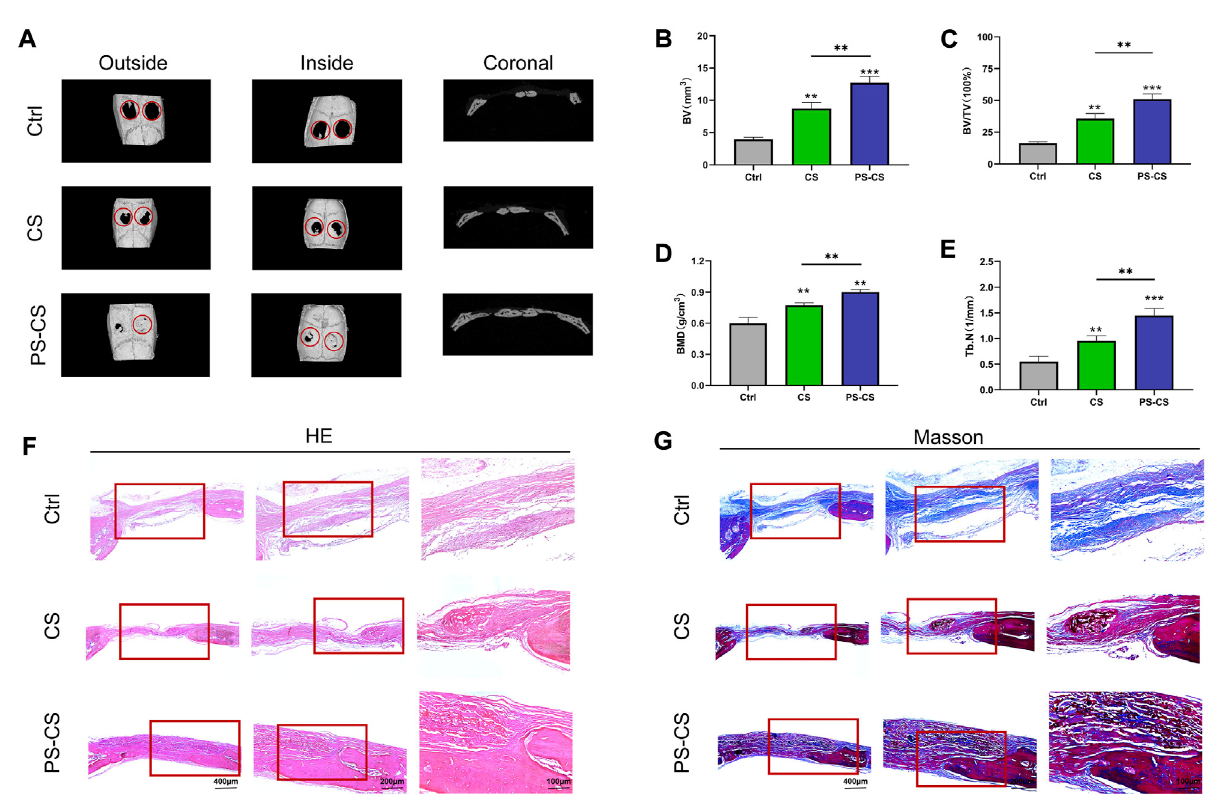
FIGURE 6 Invivo boneregeneration. (A) Micro-CTimagesofthebonedefectsinrats4weeksafterimplantationofdifferentmembranes. (B – E) Quantitativeanalysisof theboneformationinthedefects,BV (B) ,BV/TV (C) ,BMD (D) ,Th.N (E) . (F,G) HEandMasson ’ sstainingofratcranialdefectsafterimplantedwithCSmembranesor PS-CS membranes for 4 weeks. The data were analyzed statistically using analysis of variance (ANOVA). * p < 0.05; ** p < 0.01; and *** p < 0.001, **** p <